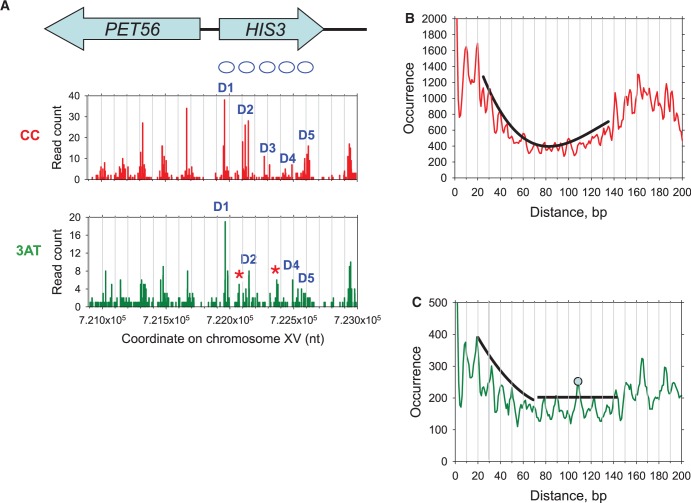
Nucleosome position clusters and distance correlation function for nucleosomes at the PET56–HIS3 locus. Only NCP sequences from this locus that were 147–152 bp in length were used for the analyses (between coordinates 721 000 and 723 000 on chromosome XV). (A) Nucleosome position clusters for the CC and 3AT sets. D1–D5: dominant positions adopted by nucleosomes on HIS3 (35). The asterisks indicate new clusters formed after 3AT induction. The numbers of sequences at each dyad position are plotted. The dyad was defined by the coordinate of the central nucleotide in each sequence; if this number was non-integral, it was rounded up. (B and C) Distance correlation function for the nucleosomes in the CC and 3AT sets, respectively. The envelope curves are shown in black. The prominent sub-peak at ∼110 bp (C) corresponds to the distance between nucleosome position D1 and the 3AT-induced position [the left asterisk in A, lower panel].